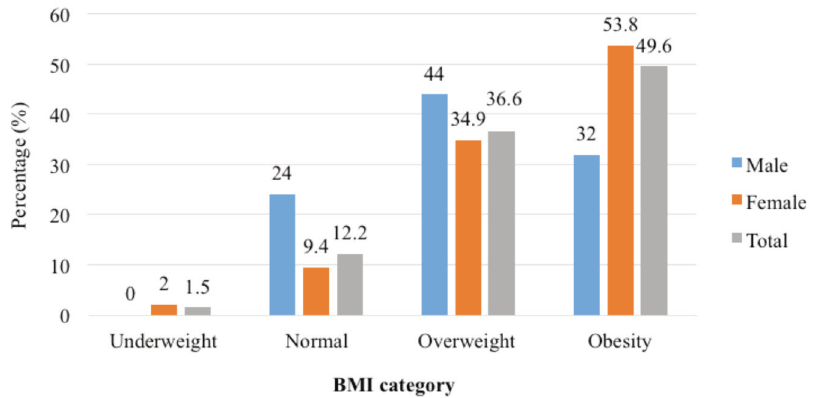
Percentage of BMI classification according to gender (n = 131). Fig. 1: